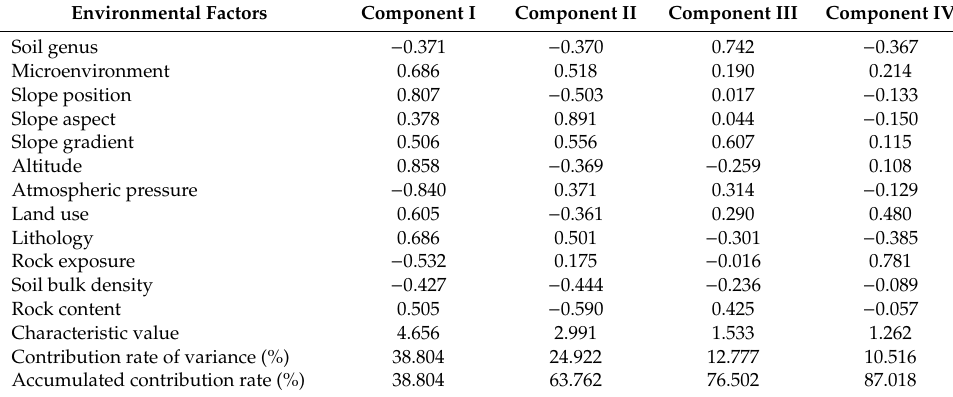
Table 3. The principal component analysis (PCA) of environmental factors via the maximum variance